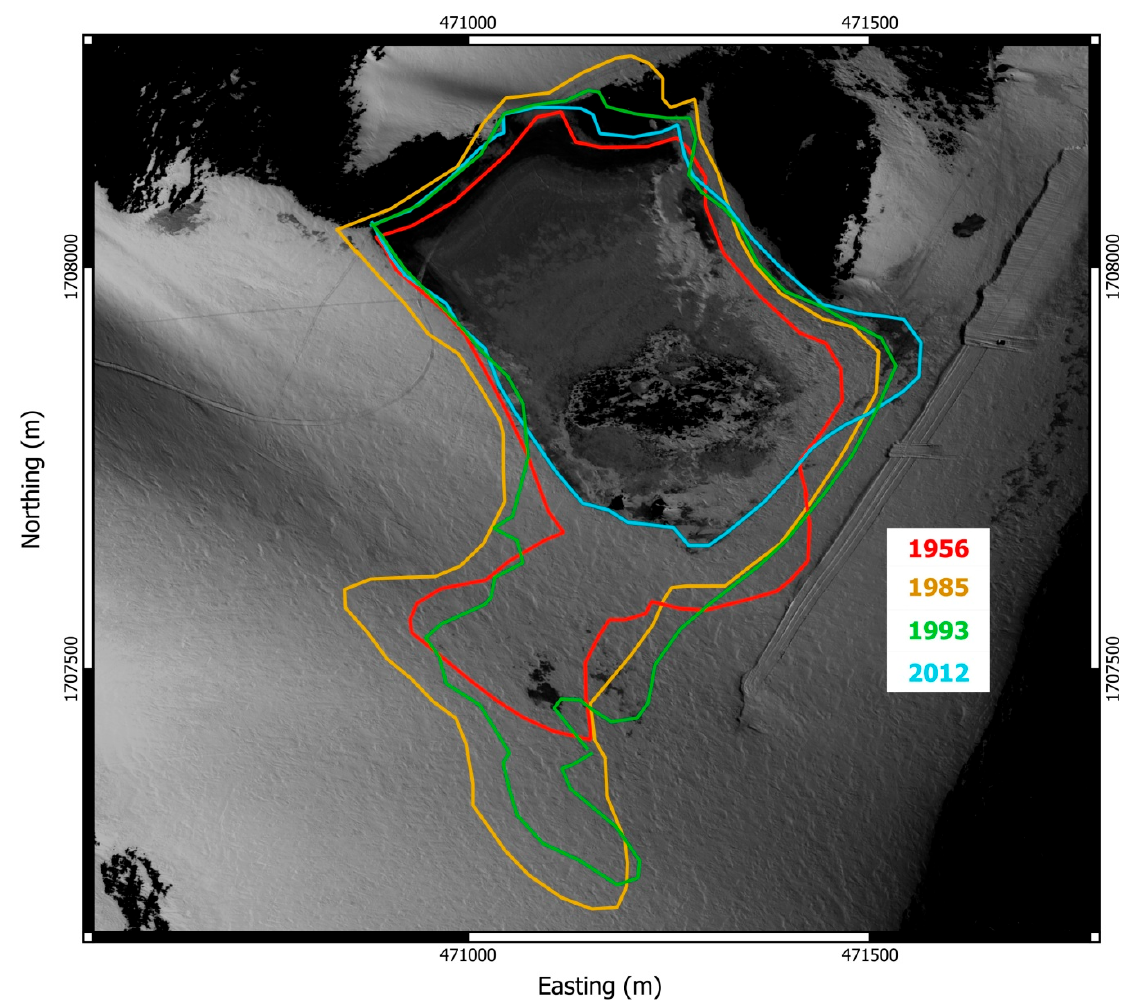
Figure 6. Enigma Lake’s variations from 1956 to 2012.